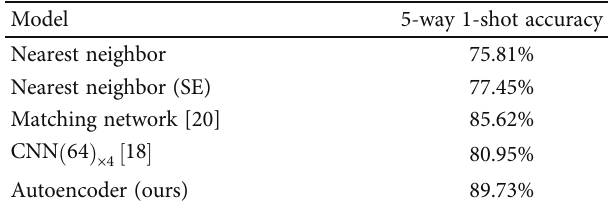
Table 2: Comparison with other models.